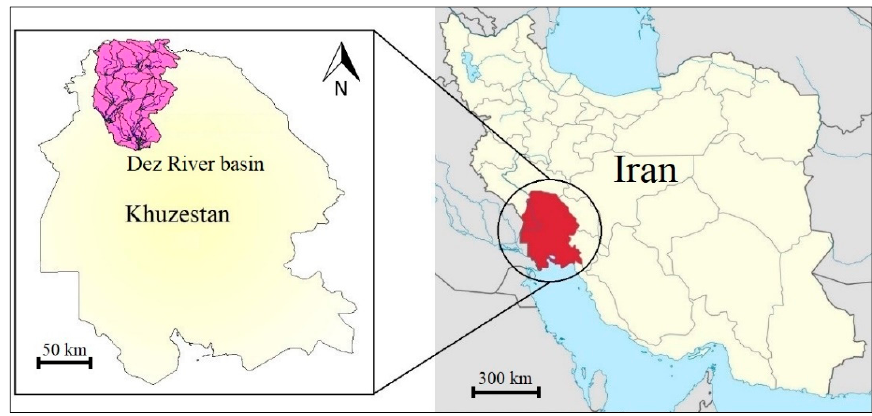
Figure 2. The geographic location of the Dez River basin.